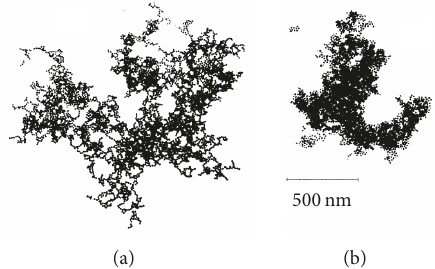
Figure 4: DLCA (a) ; dan RLCA (b) (adapted from Weitz et al.